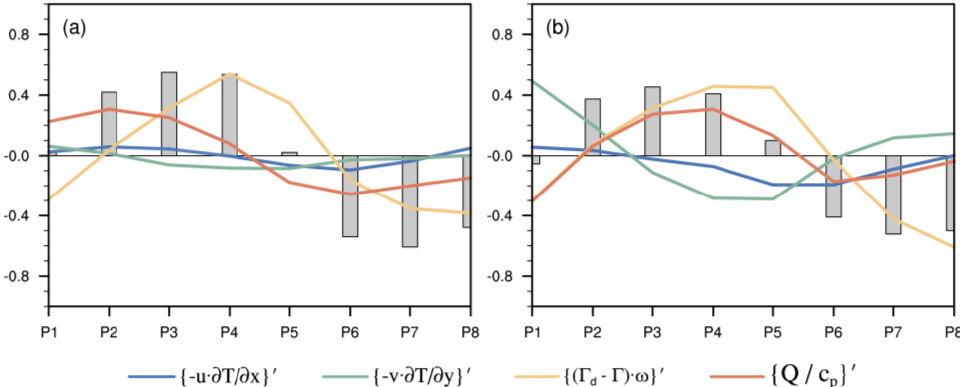
Figure 10. 10 – 30 d filtered thermodynamic equation budget terms (units: K/d) for the ( a ) first and ( b ) second type of PHTEs over Jiangnan region at 925 hPa. Terms include temperature tendency (gray bar), zonal temperature advection (blue line), meridional temperature advection (green line), adiabatic process (yellow line) and diabatic process (orange line).